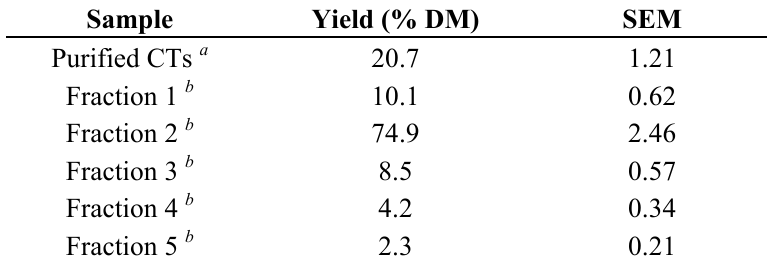
Table 1. Yields of purified and fractionated CTs from LLR by size exclusion